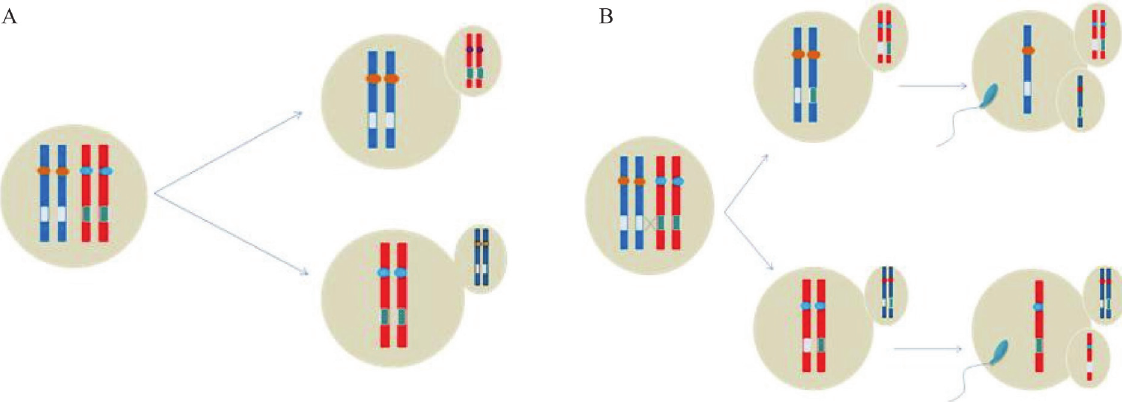
Figure 4 - Segregation with and without cross-over. (A) Normal segregation without cross-over at the level of the mutated gene. The oocyte will always have the opposite chromosome constitution to that of polar body I. (B) Normal segregation with a cross-over at the level of the mutated gene. In contrast, when exchange occurs, the egg may or may not have the